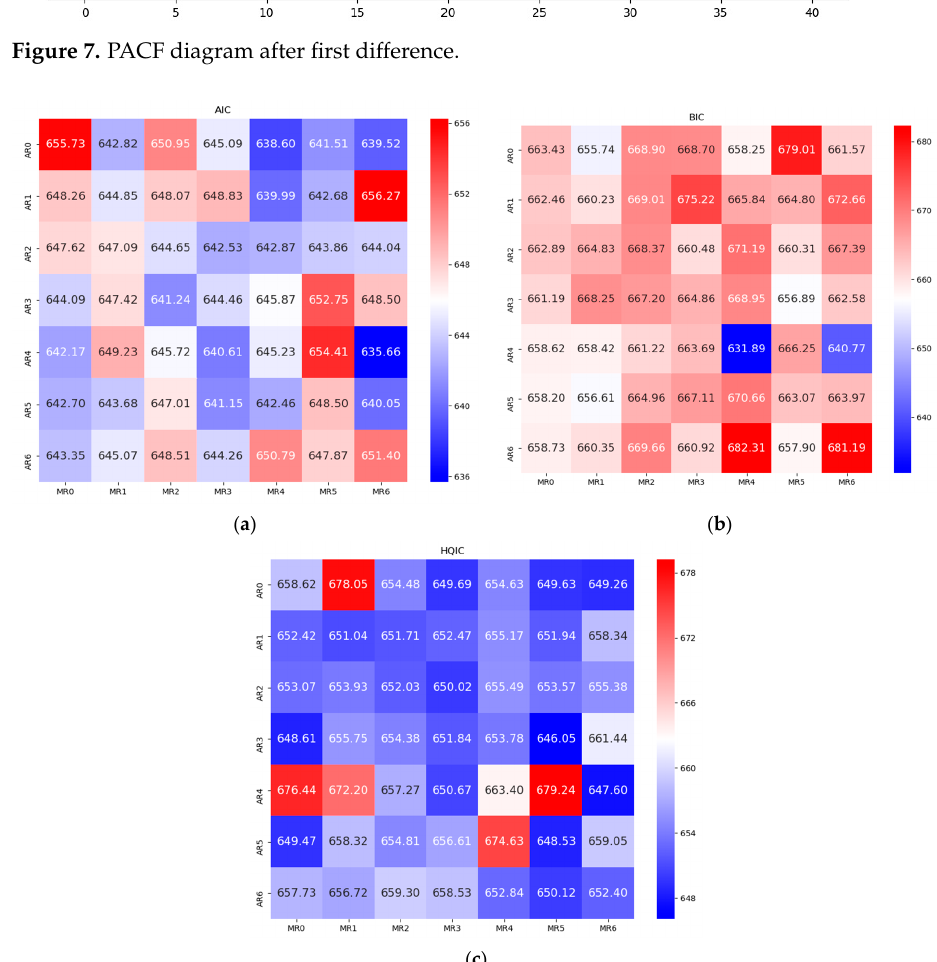
Figure 8. AIC, BIC, and HQIC values under different combinations. ( a ) AIC value, ( b ) BIC value,